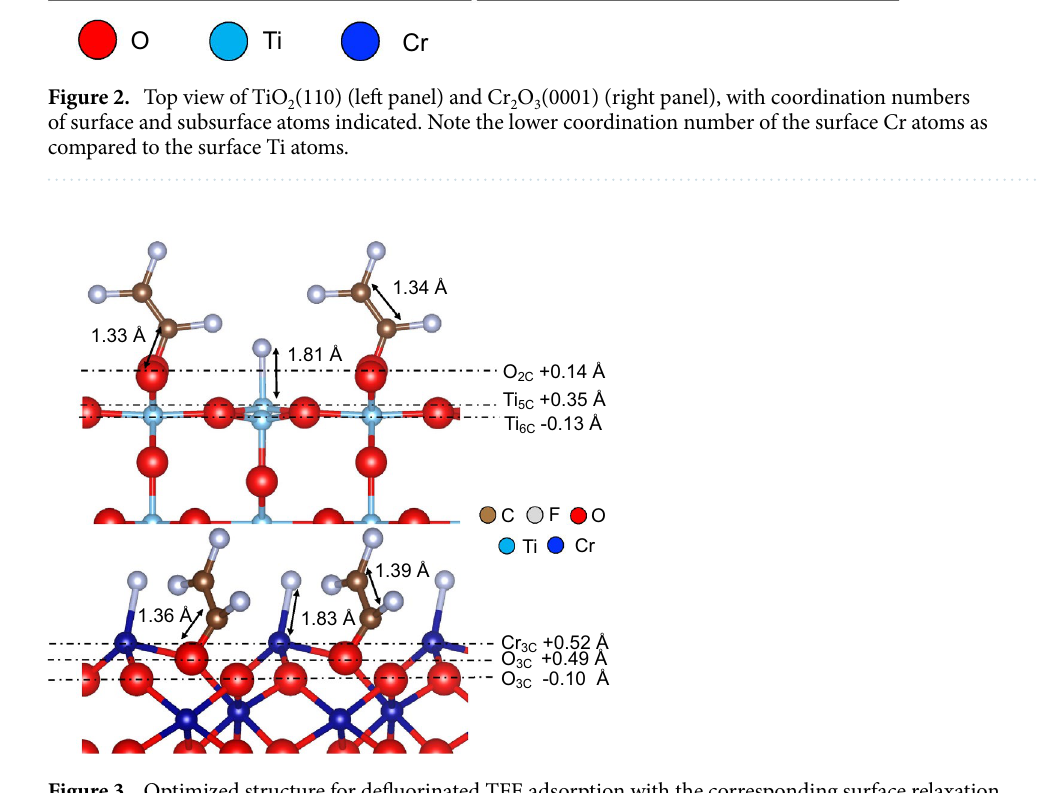
Figure 3. Optimized structure for defluorinated TFE adsorption with the corresponding surface relaxation after adsorption. (+) refers to relaxation of surface atoms towards the vacuum and (−) refers to relaxation of surface atoms towards the bulk. The values are deviations from the clean surface